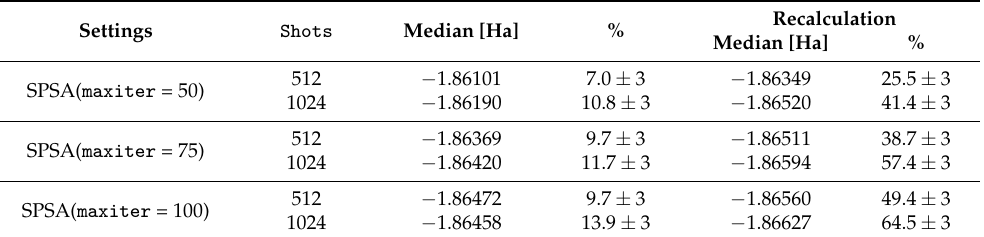
Table A3. Summary of the medians of 1000 optimized ground-state energies and the percentage of outcomes that were found within chemical precision of exact energy ( − 1.86712 ± 0.0015 Ha) for different settings for the maximum number of iterations ( maxiter ) and number of shots. The R y variational ansatz was used. An error margin of 3 percent was estimated based on the standard deviation of 1000 identically distributed trials. The rightmost two columns are the recalculation of obtained energies using the statevector simulator. These data are the basis for Figure 4.